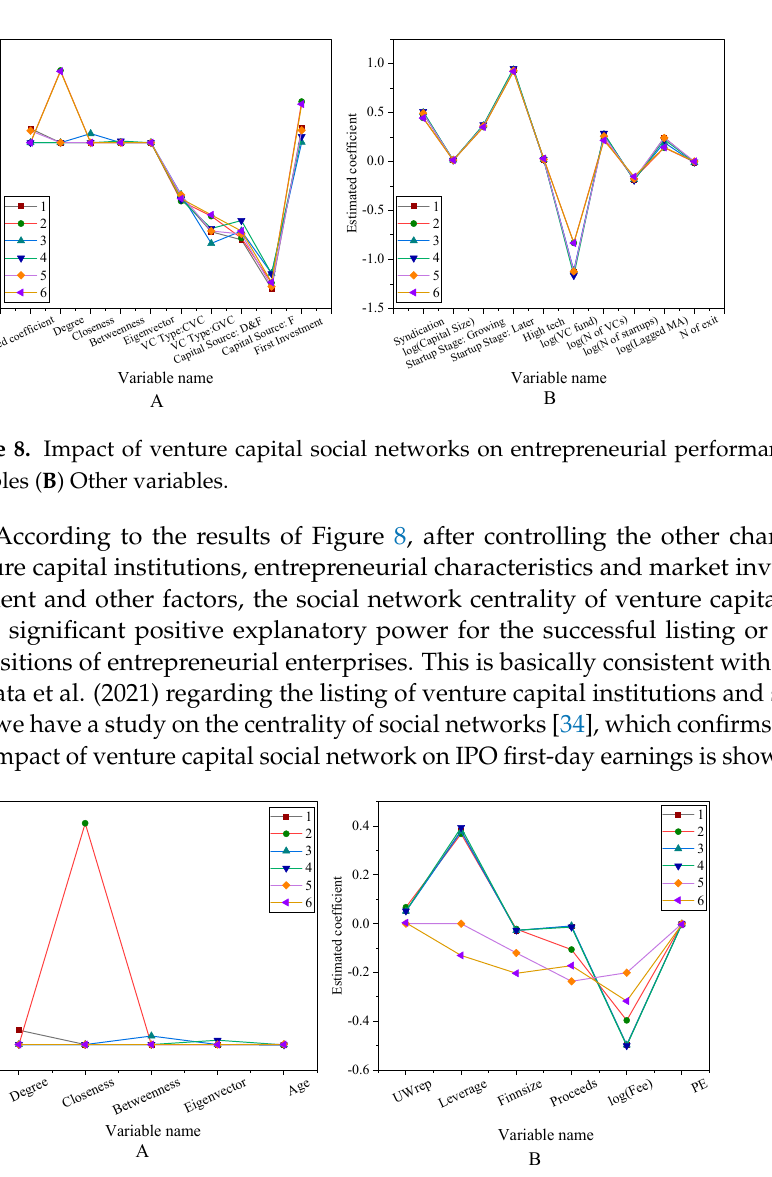
Figure 9. The impact of venture capital social network on IPO first-day earnings ( A ) First five variables. ( B ) Other variables.